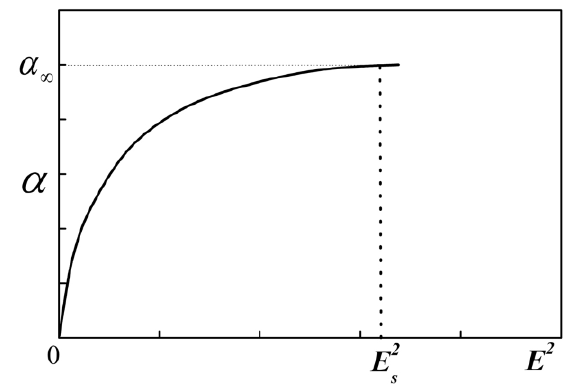
Figure 2. The electro-optical effect α as a function of the electric field intensity E ; E - the value of the electric field intensity S at the point of saturation of the